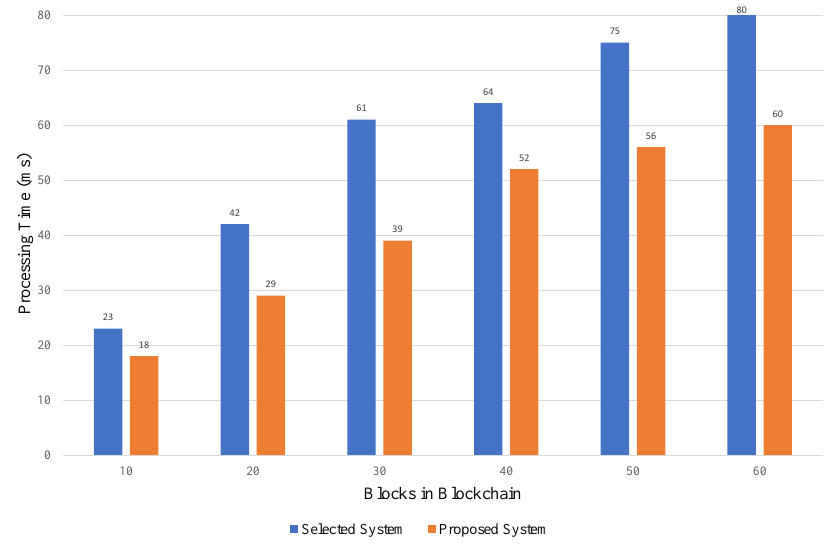
Figure 13. Comparison of processing overhead in proposed healthcare IoT